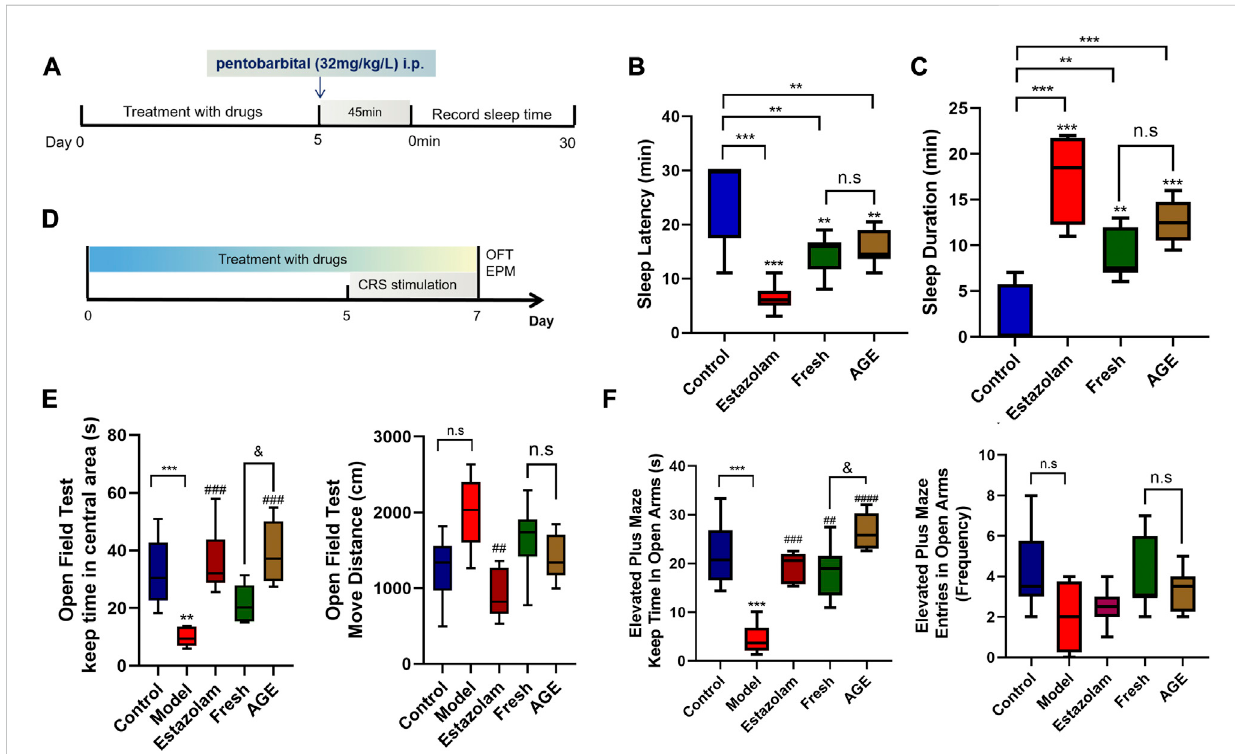
Pharmacological study effects of fresh GE and AGE. (A) The experiment design of pentobarbital-induced sleep mice ( n = 8). (B) sleep latency time (min). (C) Sleep duration time (min). (D) The experiment design ofCRS mice model ( n = 8). (E) The keep time in central areas(s) and move distance (cm) in OFT test. (F) The keep time in open arms(s) and entries in open armsin EPM test. * p < 0.05; ** p < 0.01; *** p < 0.001 represent compared with the control group.& p < 0.05representcomparedwithfreshGEandAGEgroups. p < 0.05wasconsideredstatisticallysigni fi cantcalculatedbyOne-wayANOVA followed by Tukey ’ s